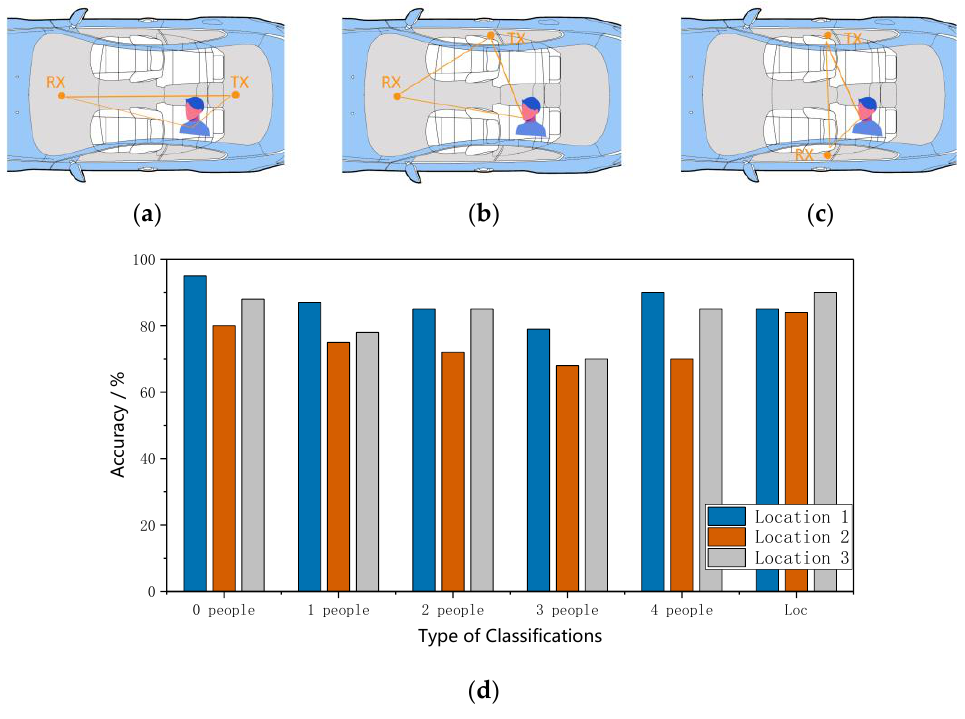
Figure 11. Comparison results of different device positions: ( a – c ) location of different equipment; ( d ) effect of different device locations on recognition accuracy.